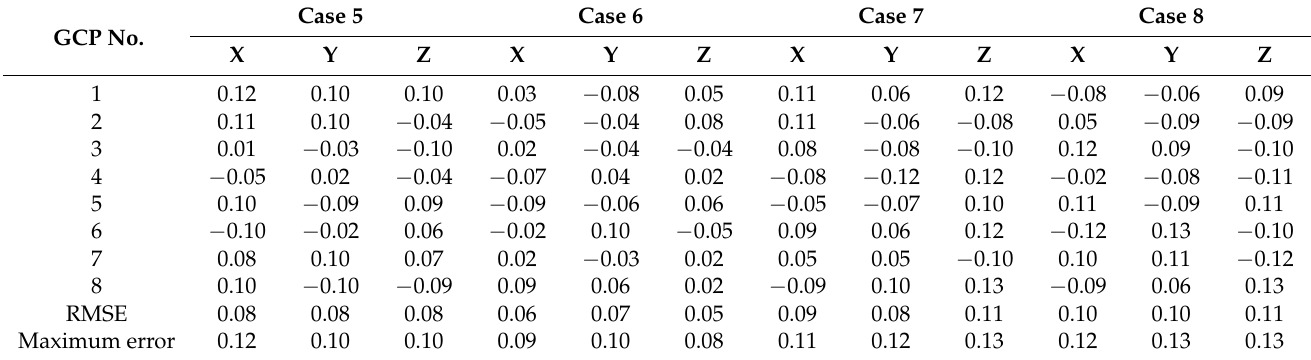
Table 7. Checkpoint errors for horizontal (x, y) and vertical (z) for orthophotos for each case at 100 m (unit: